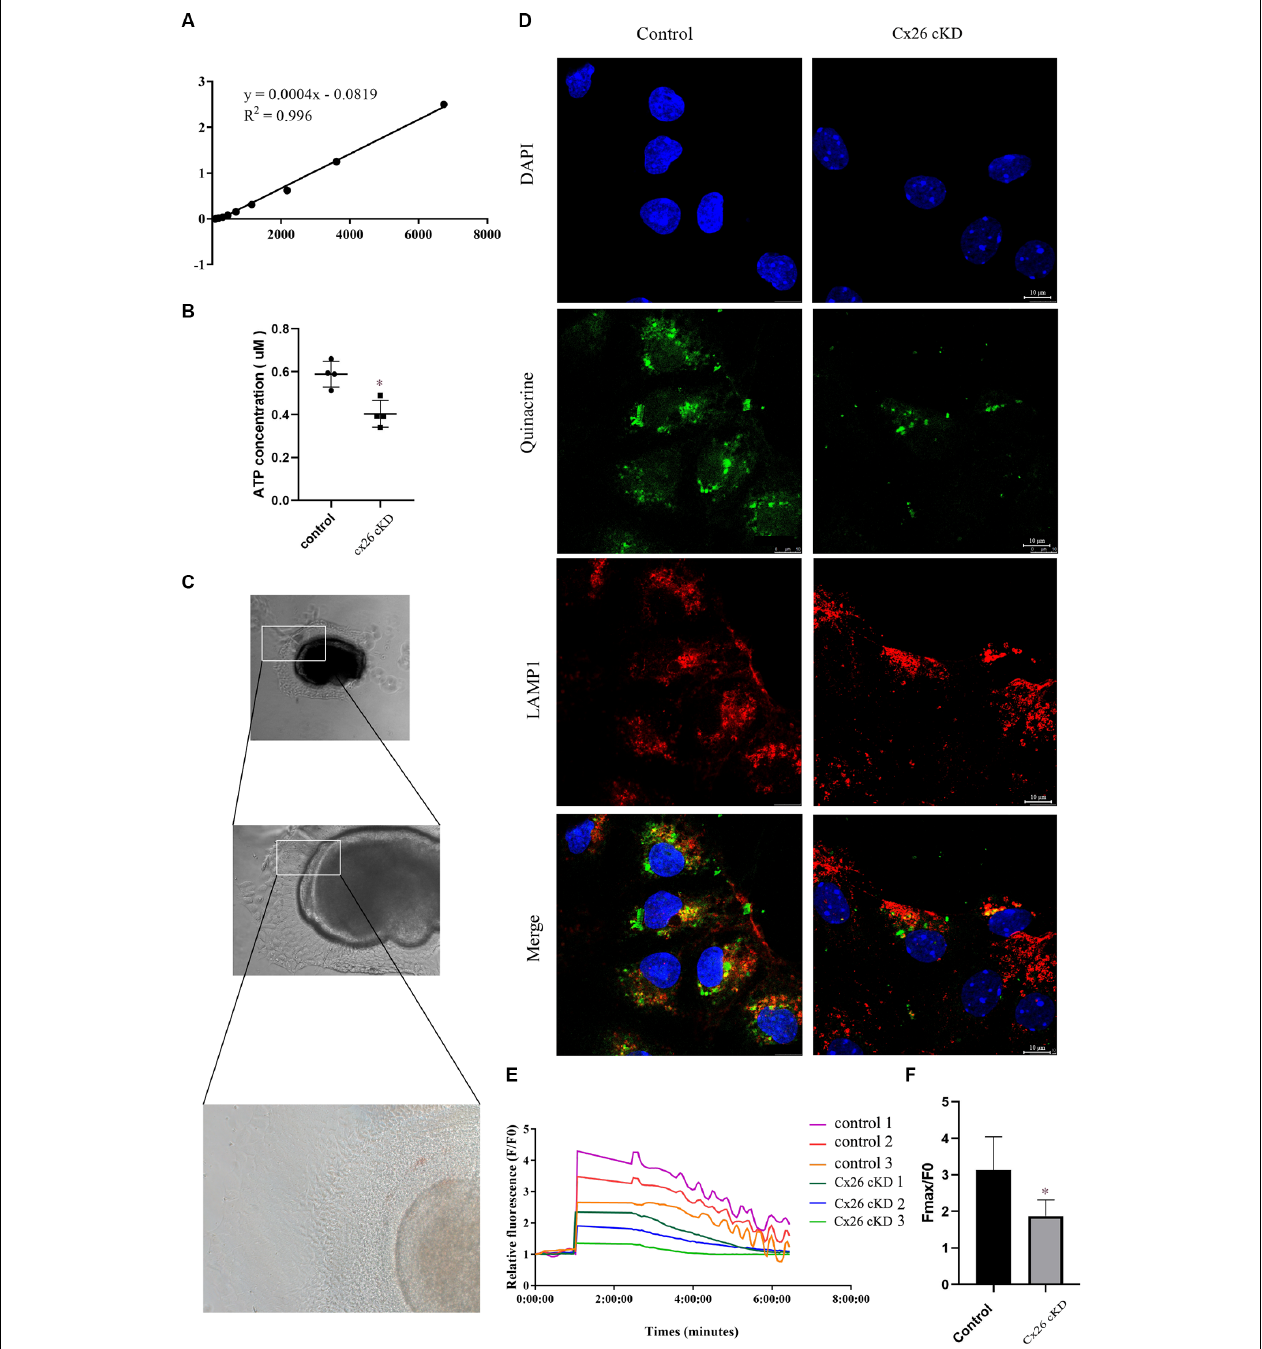
FIGURE 5 | ATP concentration and ATP-evoked Ca 2+ signaling. (A) Representative standard curve used to calibrate bioluminescence signals: Y = 0.0004X − 0.0819, R 2 = 0.996. (B) ATP concentration estimated from luciferin-luciferase bioluminescence assay. P < 0.05, n = 4. (C) Representative transmitted light microscopy image of a Kölliker’s organ culture viewed at 10 × , 20 × , and 40 × magnification (from top to bottom). (D) Representative confocal fluorescence images of Kölliker’s organ cultures labeled with quinacrine, anti-LAMP1 antibodies, and DAPI; scale bars = 10 µ m. (E) Representative ATP-evoked Ca 2+ responses of individual cells in Kölliker’s organ cultures. (F) Quantification of F max / F 0 signals; ∗ represents P < 0.05, n =